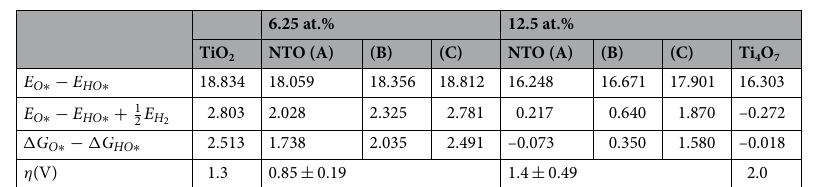
Table 1. Total energies in eV of TiO 2 , Ti 4 O 7 , and Nb-doped TiO 2 surfaces with O* and HO* adsorbates calculated using DFT and the resulting free energy differences used as predictor for the OER potential, η .